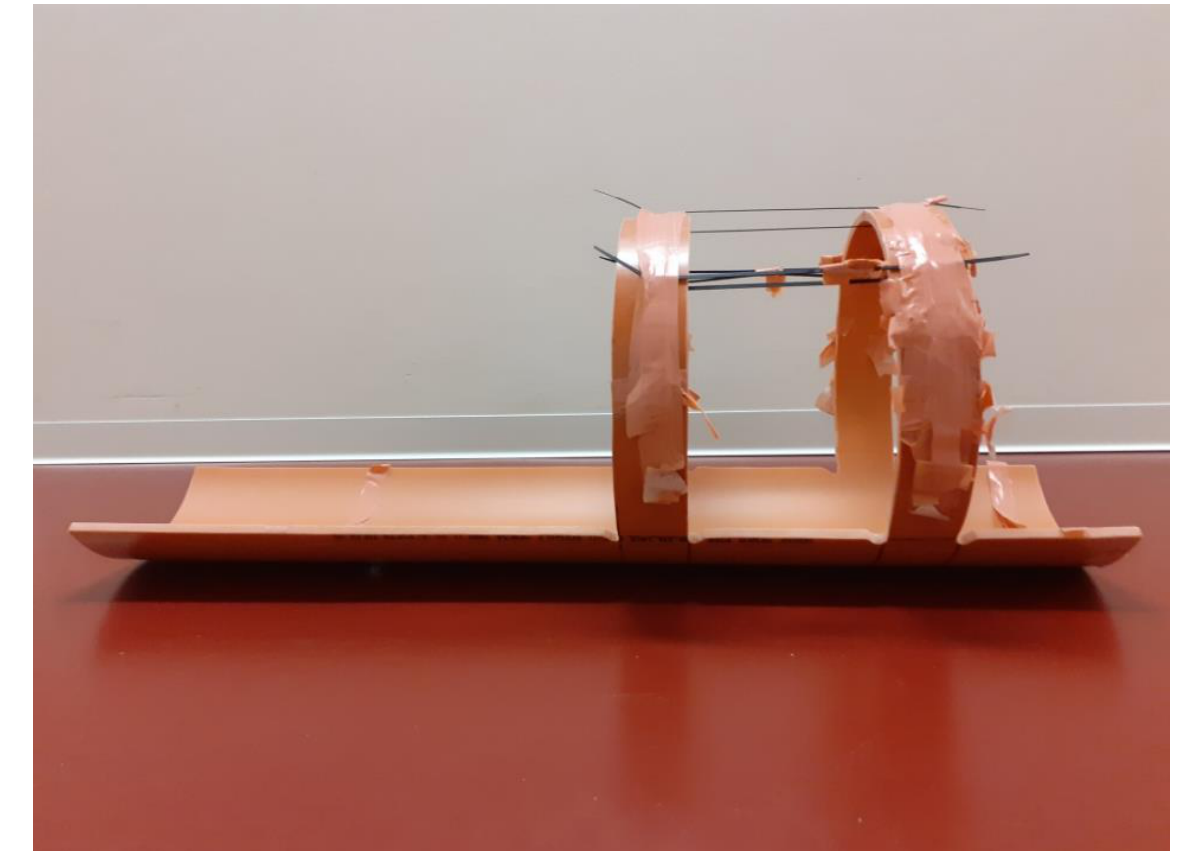
Figure 2. This homemade holder for the fixation of the pig’s hind limbs was made from a sawn-through PVC plastic tube. It is possible to fix both hind limbs with tape within the scanner’s field-of-view, which is the distance between the arches, so that the healthy hind limb can act as a control. The holder is also seen in use in Figure 1C.